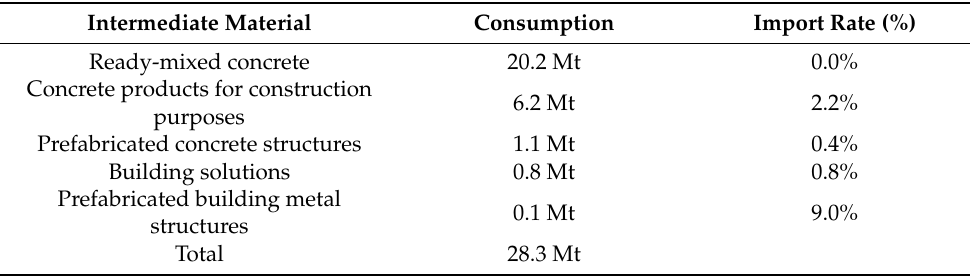
Table 2. Intermediate production and import rates of the Kazakhstani construction sector (own elaboration based on